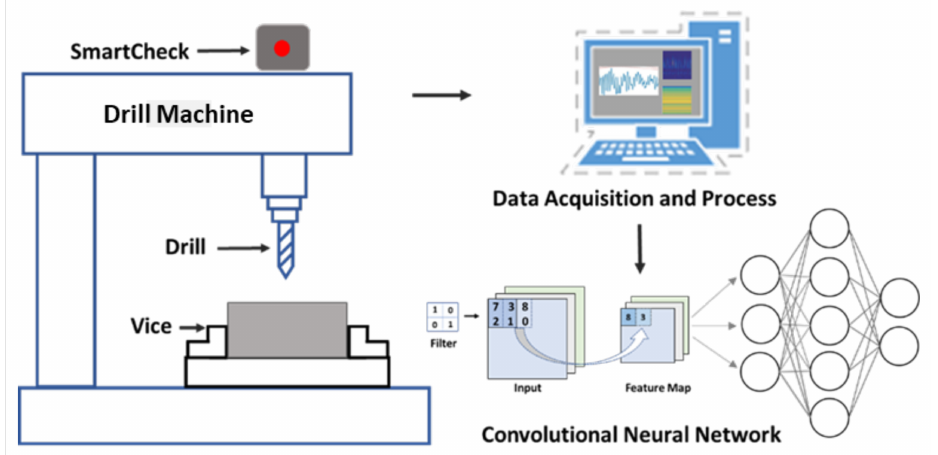
Figure 1. Schematical representation of the experimental